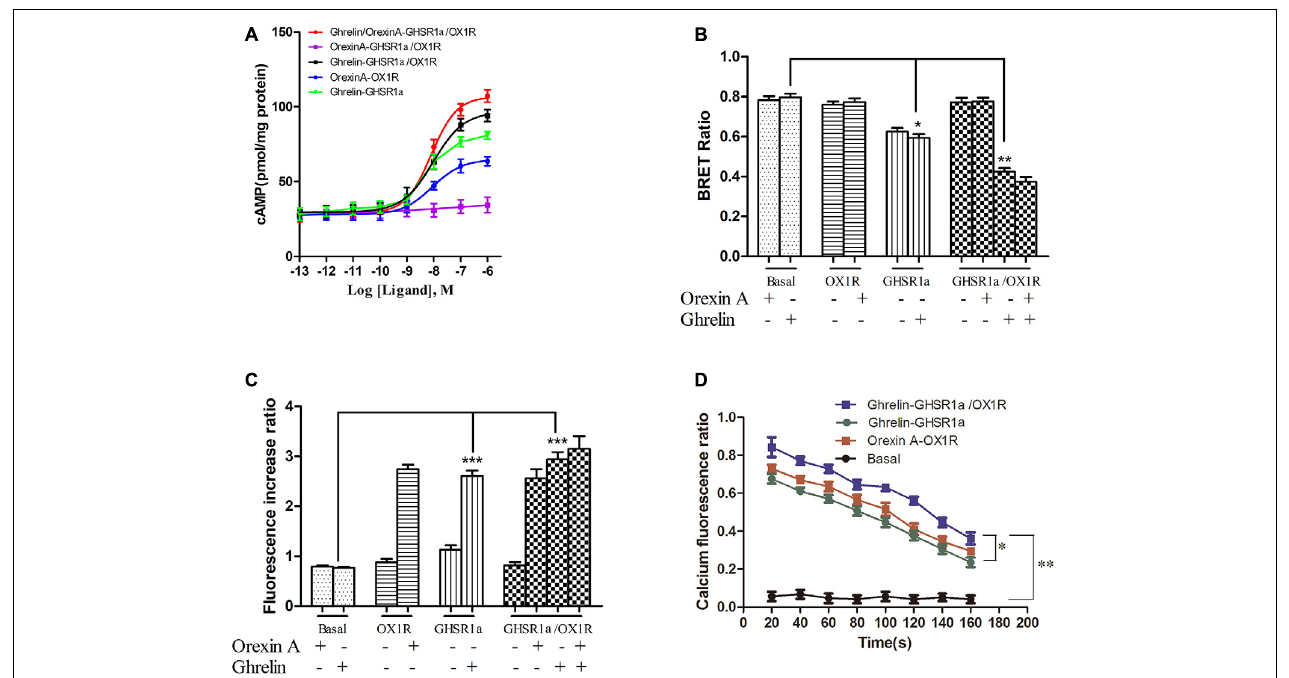
FIGURE 6 | Effect of GHSR1a/OX1R heterodimerization on intracellular second messengers. (A) ELISA assay for cAMP. HEK293-GHSR1a, HEK293-OX1R, and HEK293-GHSR1a/OX1R cells were stimulated with forskolin (10 µ M) in the absence or presence of various concentrations of orexin-A (0.001–1000 nM) and/or ghrelin (0.001–1000 nM). Intracellular cAMP concentrations were measured using an ELISA assay. Values represent the mean ± SEM ( N = 3) of three measurements from three independent experiments. The curve was fitted using nonlinear regression [log (agonist) vs. response – variable slope] in Prism 5.0. (B) BRET EPAC biosensor for cAMP monitoring. Measurement of BRET signals in HEK293 cells co-expressing the cAMP biosensor and GHSR1a, OX1R, or GHSR1a/OX1R and stimulated with ghrelin and/or orexin-A. ∗ p < 0.05; ∗∗ p < 0.01. The data are expressed as the mean ± SEM ( N = 3) of four independent experiments. (C) Intracellular calcium assay. HEK293 cells stably expressing GHSR1a, OX1R, or GHSR1a/OX1R were treated with ghrelin (100 nM) or orexin-A (100 nM). The fluorescence intensity of intracellular calcium was recorded 20 s after stimulation using a Fluo-4 NW Calcium Assay Kit. Untransfected cells were used as a control. The results are the mean ± SEM ( N = 3) of at least four independent experiments. Statistical analysis was performed using one-way ANOVA followed by Tukey’s multiple comparison post hoc test. ∗∗∗ p < 0.001 vs. basal groups. (D) Time-dependent activation of intracellular calcium by ghrelin or orexin-A in HEK293-GHSR1a, OX1R, or GHSR1a/OX1R cells. The intracellular calcium concentration was detected as described above. The statistical analyses were performed with SPSS (version 19.0). It was found that there are differences in different time results, and there are differences among different groups at different times (20, 80, and 140 s). The results of the comparison between the two groups showed that there was a statistical difference between the basal group and the other three groups ( P < 0.01), and there was a statistical difference between double-transfected cells group and single-transfected cells group ( P = 0.042, P =